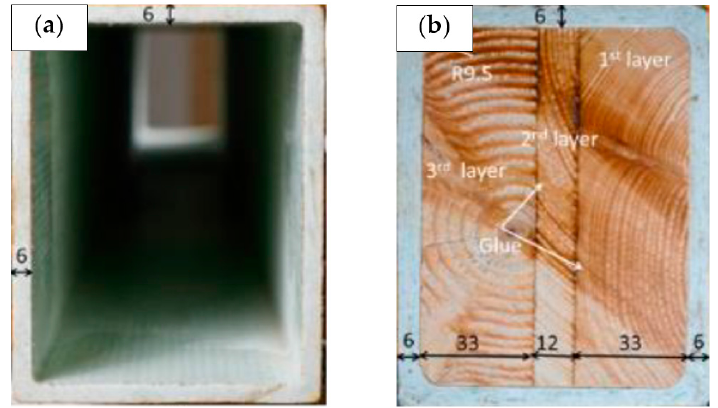
Figure 16. Structural improvement of ( a ) pGFRP square hollow beam by ( b ) insertion of balsa wood core. Reproduced with copyright permission from Zhang et al. [133]. core. Reproduced with copyright permission from Zhang et al.